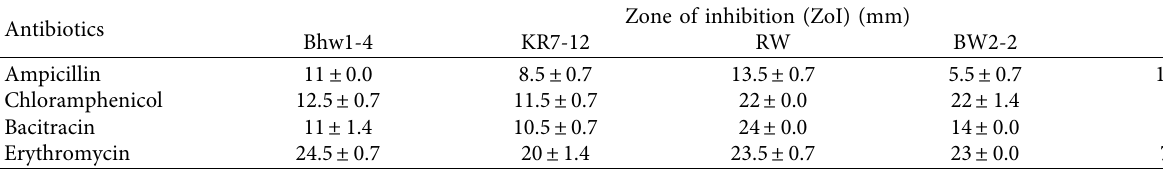
Figure 4: Hydrolysis test of the isolates. Table 2: Antibiotic sensitivity test.